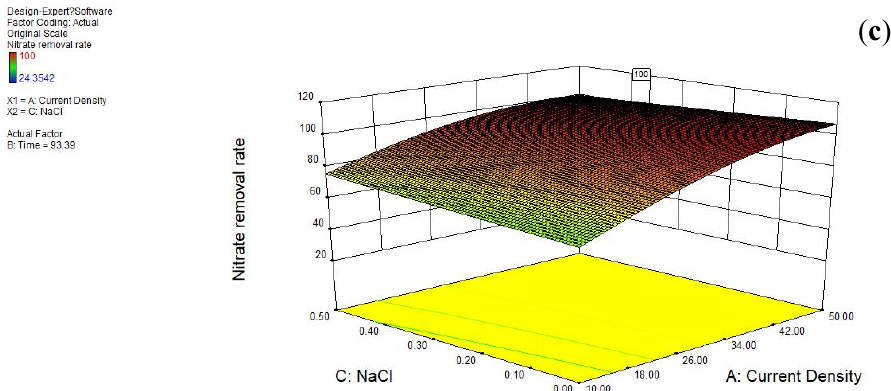
Figure 7. ( a ) Current density and reaction time, ( b ) reaction time and NaCl content, and ( c ) NaCl content and current density on nitrate removal of 3D three-dimensional standard deviation.